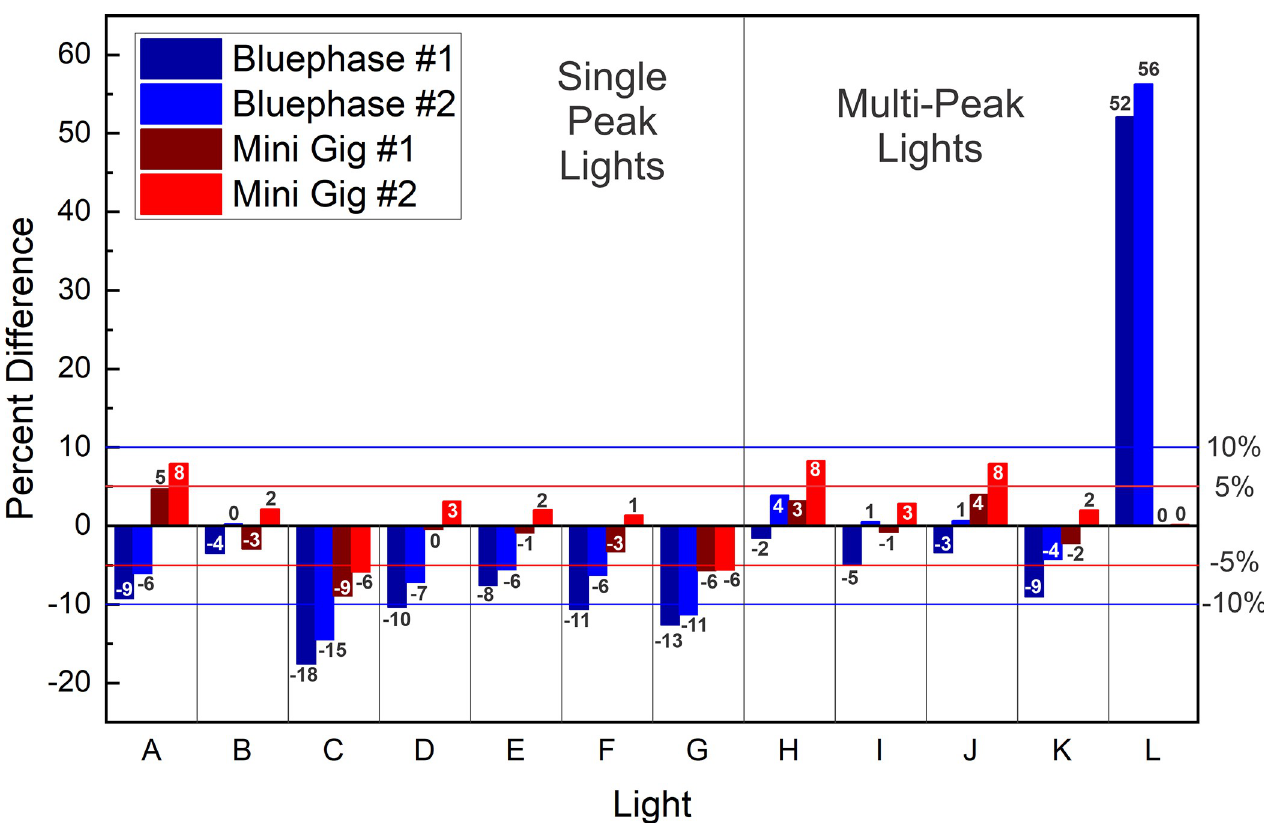
Fig 7. Percentage difference in the power values between radiometer units #1 and #2 compared to the ‘GS’ integrating sphere power values measured from unit #1 of each brand of LCU. Single Peak LCUs A) SmartLite Pro; B) DeepCure; C) Dental Spark; D) Denjoy; E) Woodpecker LED D; F) Woodpecker LED B; G) SDI Radii Plus; and Multi-peak LCUs H) Valo Grand; I) Bluephase G4; J) Valo; K) Bluephase Powercure; and L)